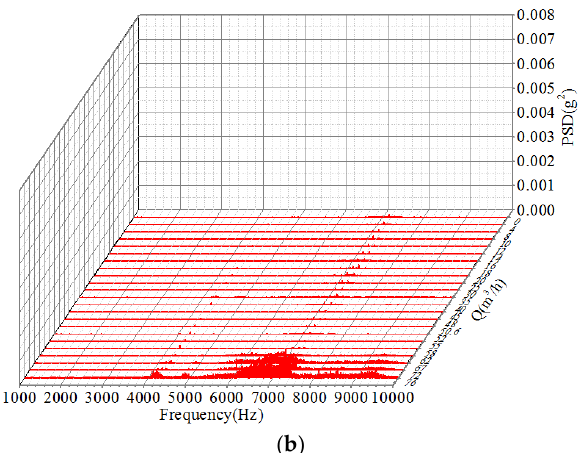
Figure 8. PSD of the vibration measured by accelerometer 2 under different flow rates. ( a ) 0 – 400 Hz, ( b ) 1 – 10 kHz.